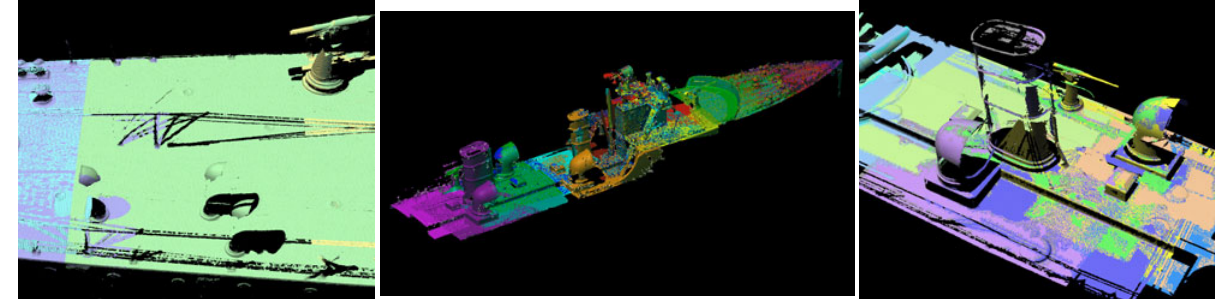
Figure 8: The mesh of the main deck is characterised by gaps and shady